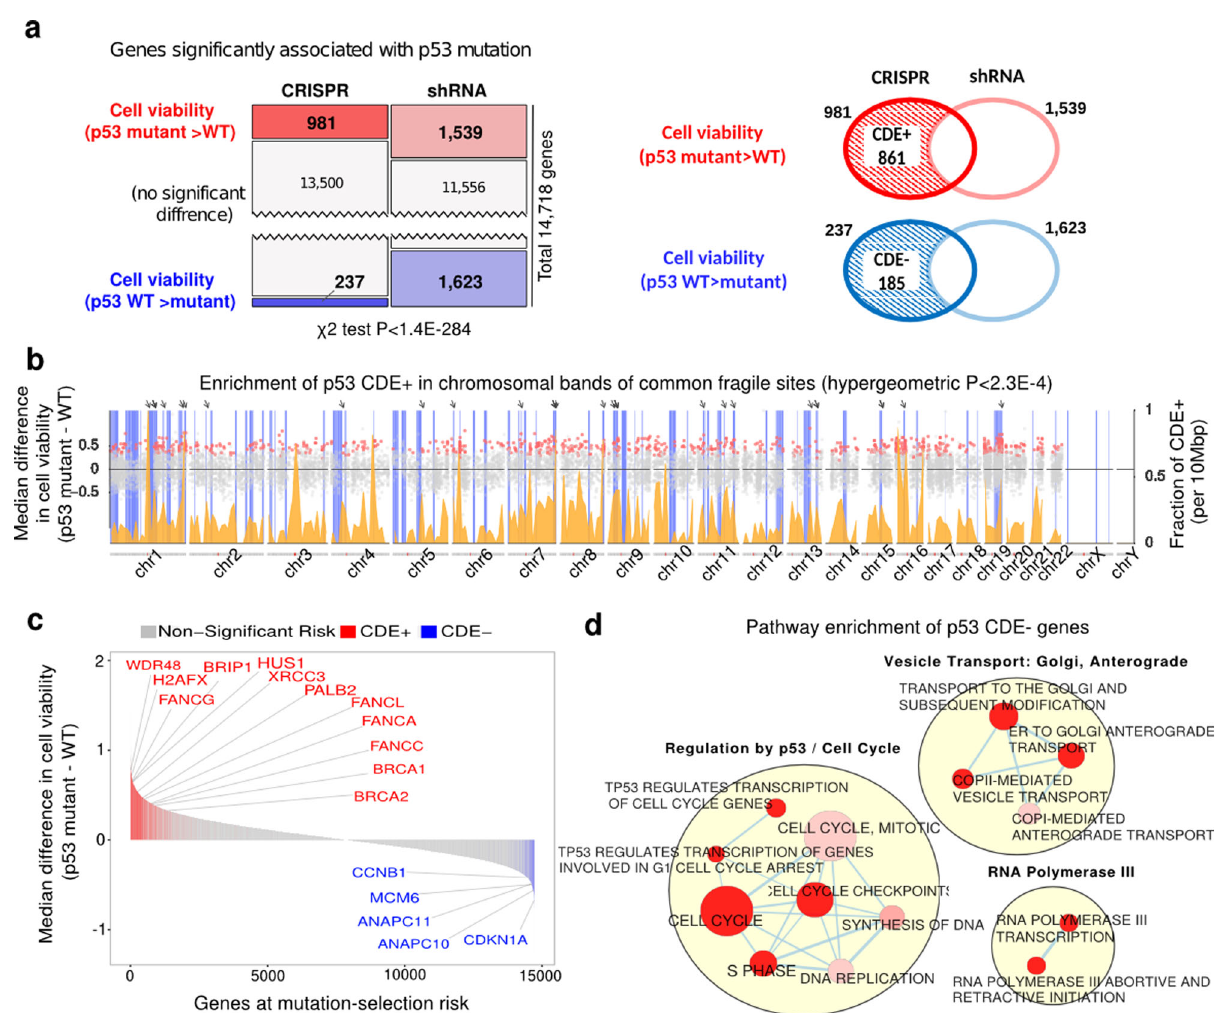
Fig. 1 A genome-wide view of p53 -mutant selection. a Upper panel: number of genes whose essentiality is signi fi cantly associated with p53 mutation status in CRISPR and shRNA screens (one-sided Wilcoxon rank-sum has been performed with FDR threshold of 0.1). Lower panel: the de fi nition of CDE + and CDE − genes. b Enrichment of p53 CDE + genes in common fragile sites (CFSs). The x -axis denotes the chromosomal position; the scatter plot ( y -axis on the left-hand side) shows the difference of median post-CRISPR-KO cell viability values in p53 mutant vs. p53 WT cell lines for p53 CDE + genes (red dots) and all other genes (gray dots); the density plot (colored orange, y -axis on the right-hand side) shows the fraction of p53 CDE + genes among all genes per DNA segments of 10 Mbp along the genome; the vertical blue bars indicate the chromosomal bands of CFSs, and prominent sites where peaks of high CDE + gene density coincide with CFSs are marked by arrows on the top. c The distribution of predicted level of CRISPR-Cas9 p53 -mutant selection across the genome. Signi fi cant CDE + genes that are part of the FA pathway are marked in red and signi fi cant CDE − genes that are part of cell cycle regulation are in blue. d Visualization of the pathways enriched for p53 CDE − genes where signi fi cance is calculated using the GSEA method as implemented in the R package fgsea 38 . Only signi fi cantly enriched pathways (FDR < 0.1) speci fi c to CRISPR (and not in genes showing differential essentiality in the shRNA screens are shown). Pathways are depicted as nodes whose sizes correlate with pathway lengths and colors represent enrichment signi fi cance (the darker, the more signi fi cant). Pathway nodes are connected and clustered based on their functional similarities, and higher- level functional terms are given for each of the clusters (see the “ Methods ” section). For clarity, only the largest clusters are